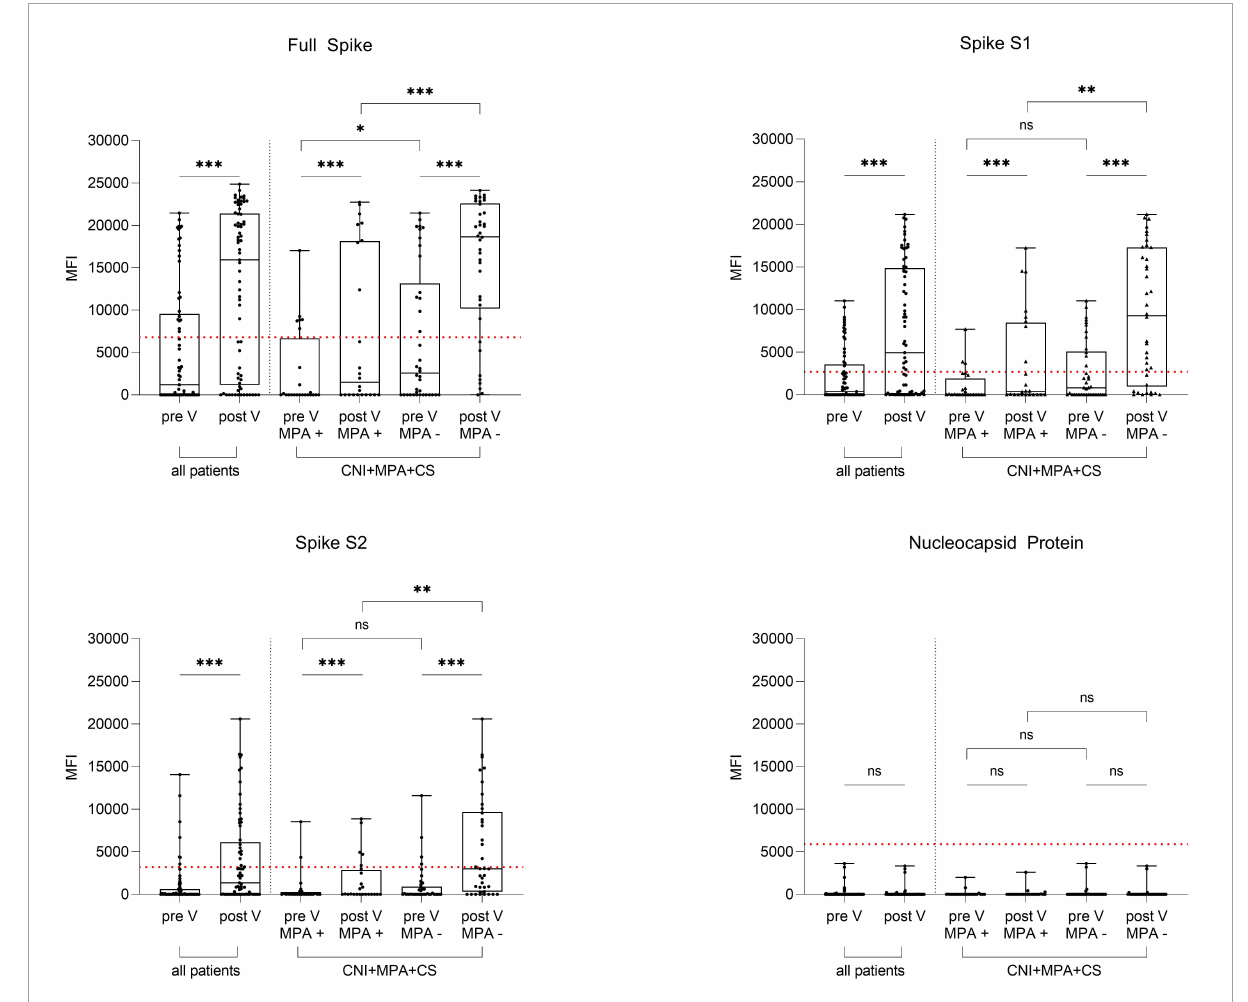
FIGURE3 IgG antibodies against the full spike, the spike S1 and S2 subunits and the nucleocapsid protein in 69 kidney transplant recipients before and after an additional mRNA-1273 vaccine dose. IgG antibodies targeting the SARS-CoV-2 full spike (upper left panel), the spike S1 (upper right panel) and S2 subunits (lower left panel), and the nucleocapsid protein (lower right panel) were determined in 69 kidney transplant recipients (KTR) before and after additional vaccination using a multiplex bead-based assay. Results were stratified for 62 patients with triple immunosuppressive therapy consisting of a calcineurin inhibitor (CNI), mycophenolic acid (MPA), and corticosteroids (CS) according to temporary MPA withdrawal during vaccination (MPA + vs MPA -). KTR with breakthrough infections ( N = 9) were excluded from all analyses. The dashed red line indicates the cut-off for each respective target. CNI, calcineurin inhibitor; CS, corticosteroids; KTR, kidney transplant recipients; MFI; mean fluorescence intensity; MPA, mycophenolic acid; V, vaccination; ∗∗∗ P < 0.001; ∗∗ P < 0.01; ∗ P < 0.05; ns,